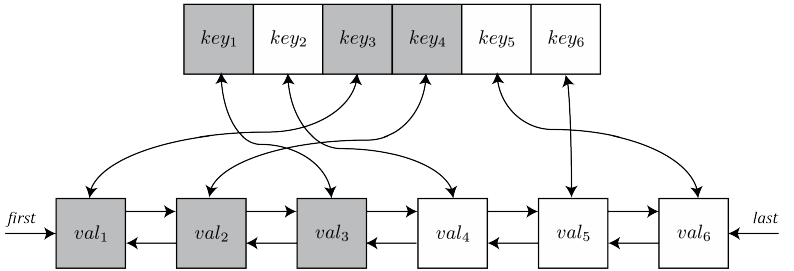
Figure 2. Graphical illustration of the Least Recently Used (LRU) cache optimization